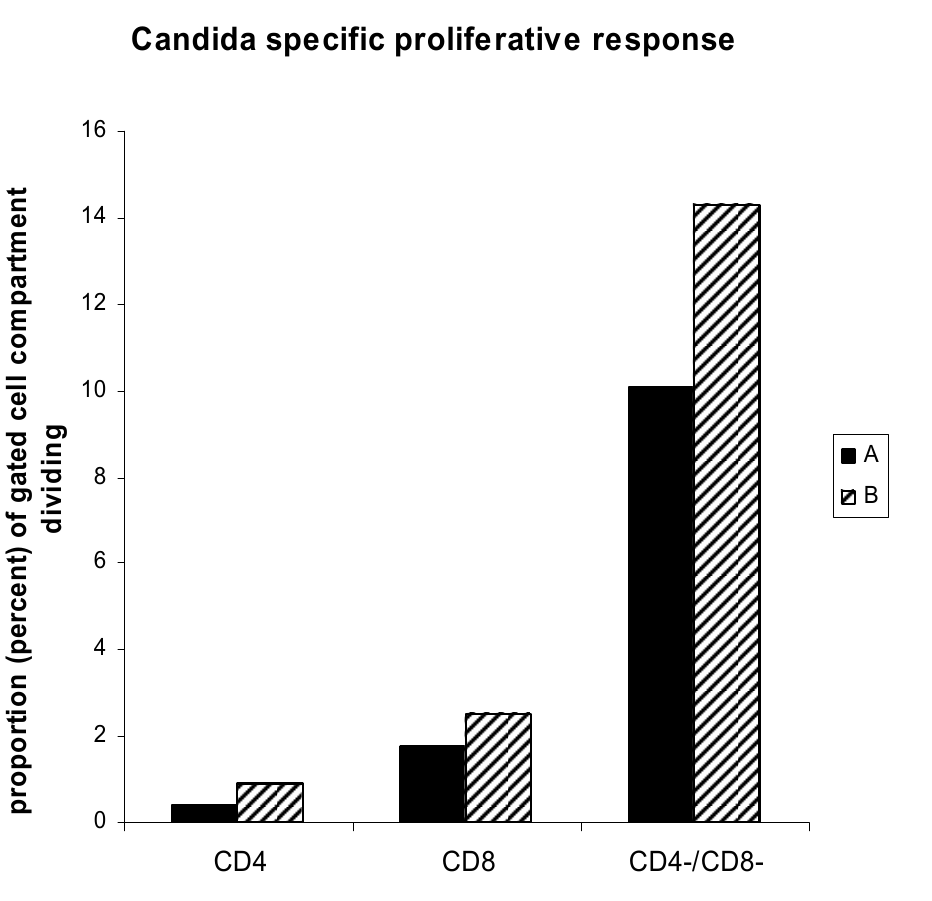
Figure 6. Soluble antigen specifc proliferative response also entails a substantial non-T cell bystander component. PBMC from two individuals with candida specific IL-2 and IFN-  secreting CD4 T cell populations (identified in Figure 1 as CD4 T cell mediated activity) were analyzed by CFSE dye dilution analysis of 6 day antigen specific proliferation reactions. Analysis of CD4, CD8, and CD4-/CD8- cell fractions proliferating in response to soluble antigen are represented for each